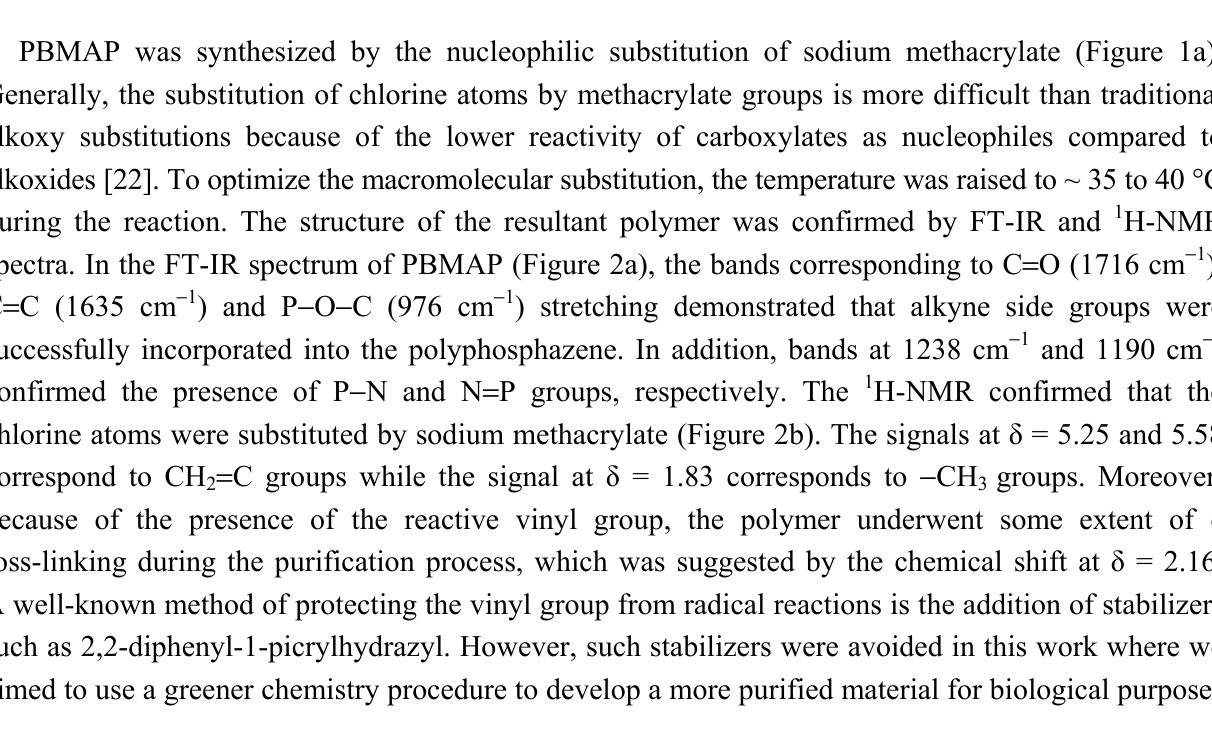
Figure 1. Schematic representation of ( a ) PBMAP hydrogel fabrication and ( b ) enzyme